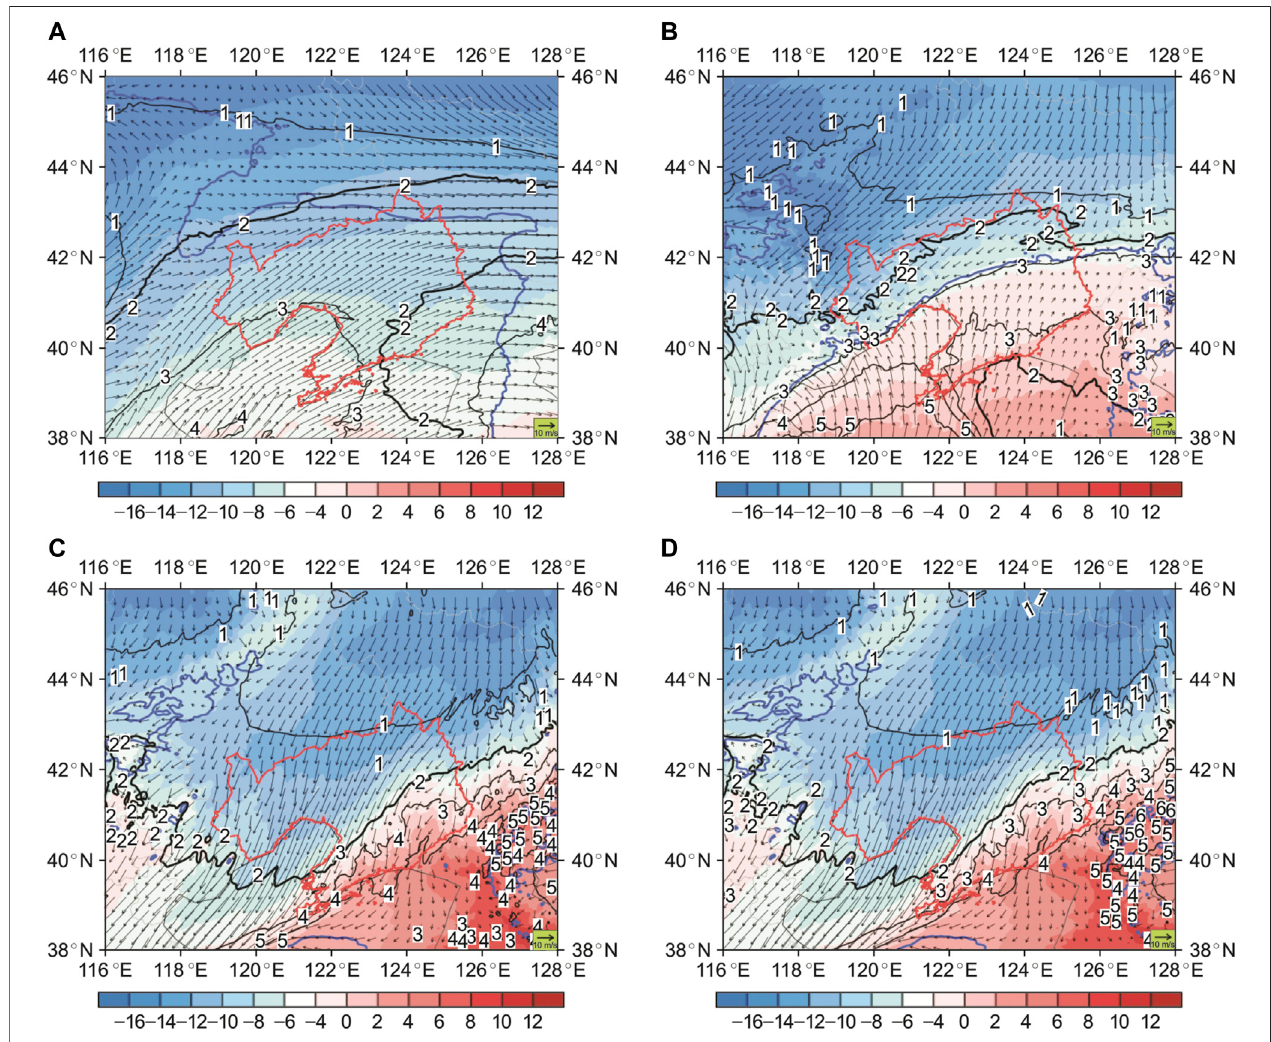
FIGURE7| Temperature,speci fi chumidity,andwindat700 (A) ,850 (B) ,925 (C) ,and975 (D) hPaat8:00onDay1(unit,temperature: ° C,speci fi chumidity:g/kg, wind speed: m/s, blue bold solid line: wind shear lines).